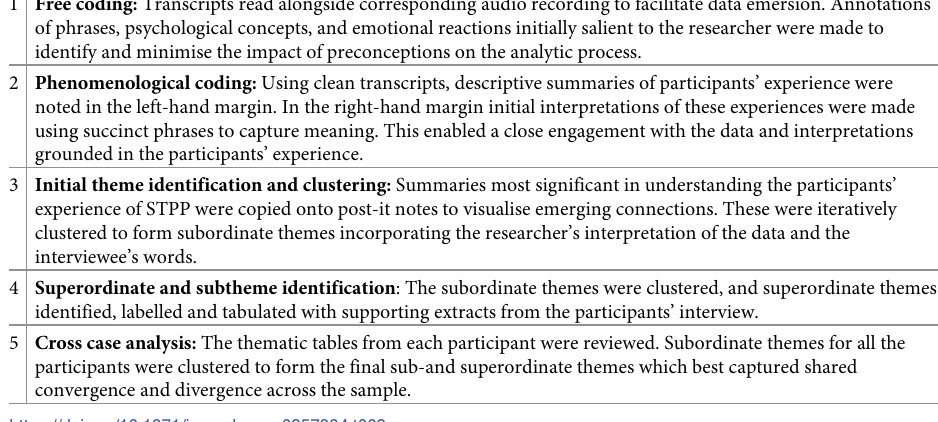
participation in the research study [31]. Interviews were carried out at a location chosen by the